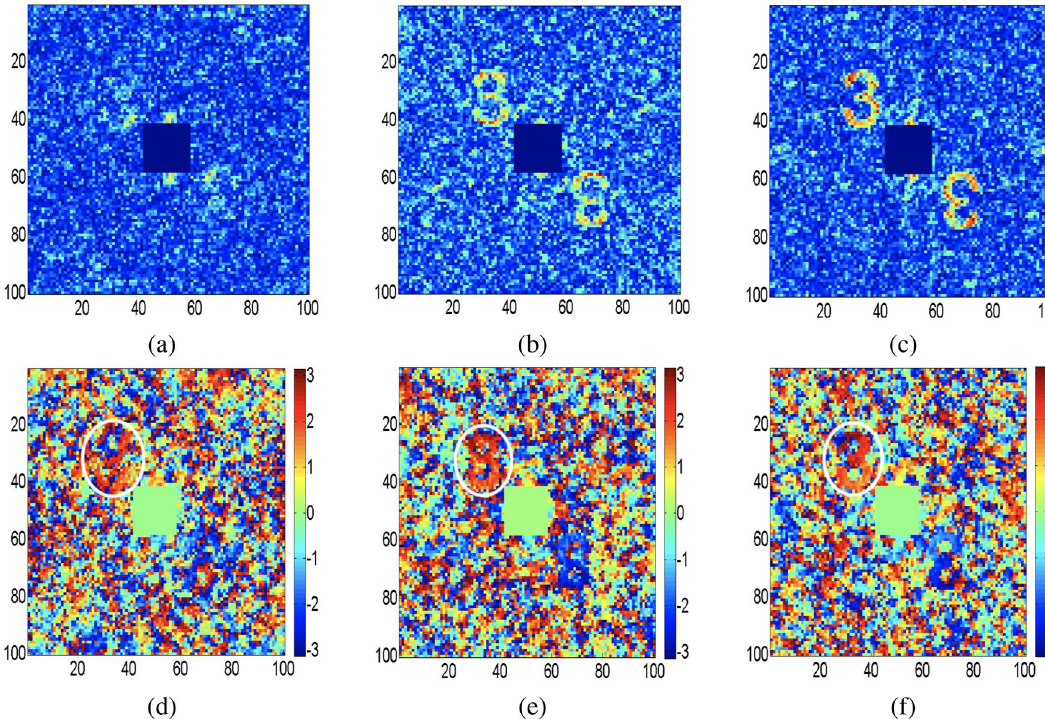
Figure 5. Recovery of the complex fields using STICH for three different M values: an off-axis hologram of number “3” is used as transparency ( a , d ) Amplitude and phase distribution of object for M = 200 ; ( b , e ) Amplitude and phase distribution of object for M = 500 ; ( c , f ) Amplitude and phase distribution of object for M = 1000 .